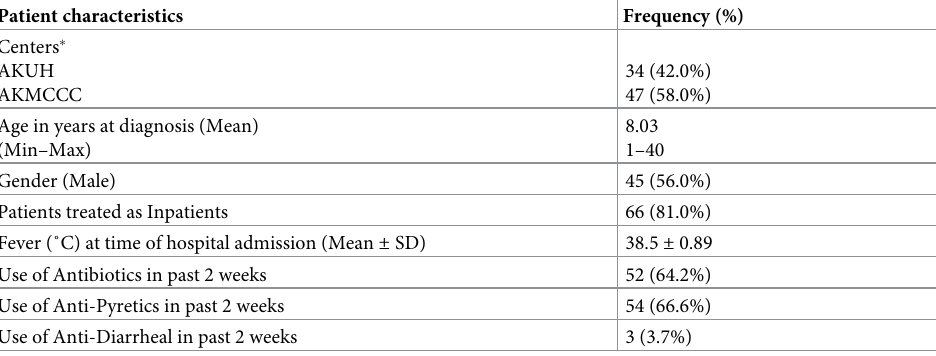
Table 1. Demographic characteristics and treatment of culture proven XDR Typhoid patients (N = 81).